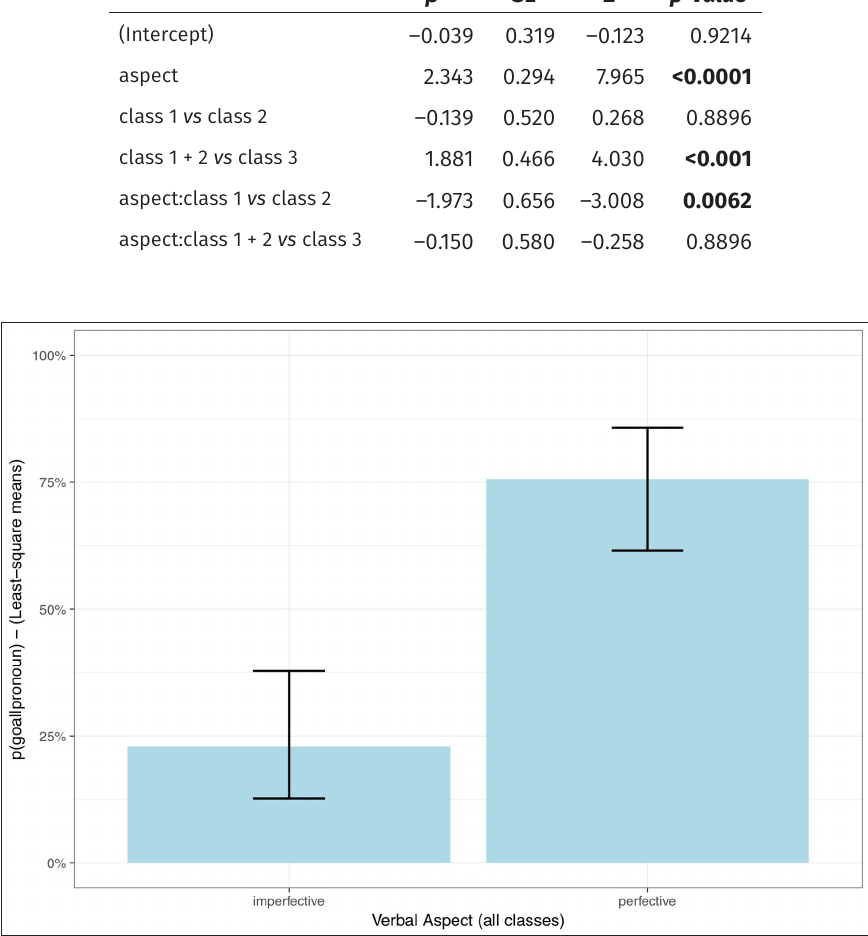
Table 3: Effects of verbal aspect and verb class on pronoun interpretation.